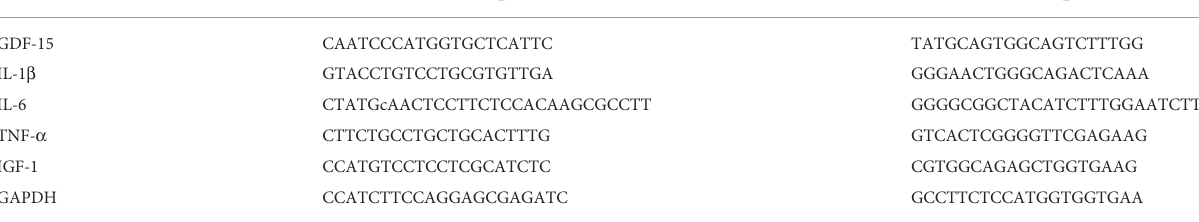
TABLE 1 Sequence of each